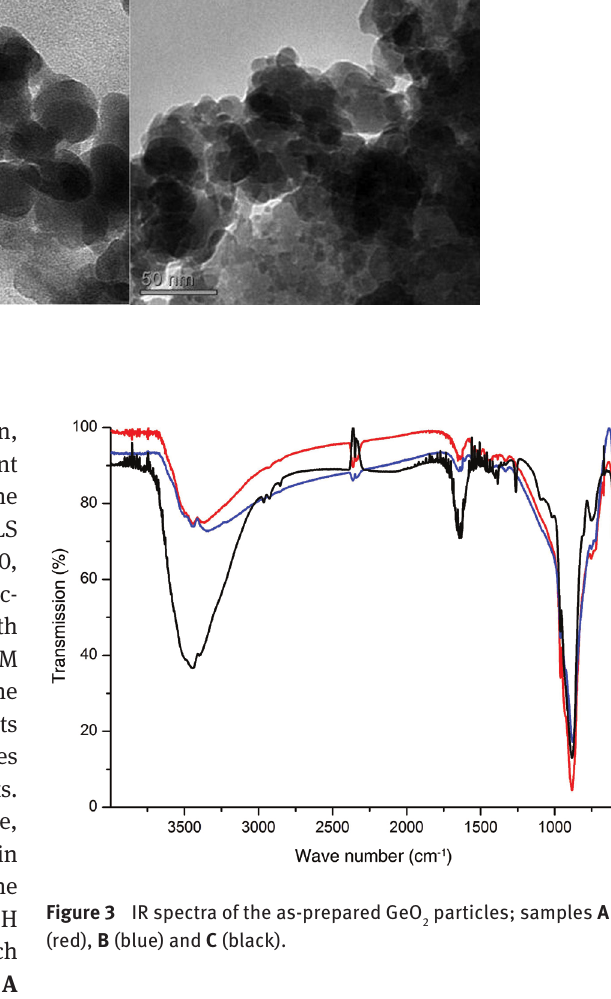
Figure 3 IR spectra of the as-prepared GeO (red), B (blue) and C (black).